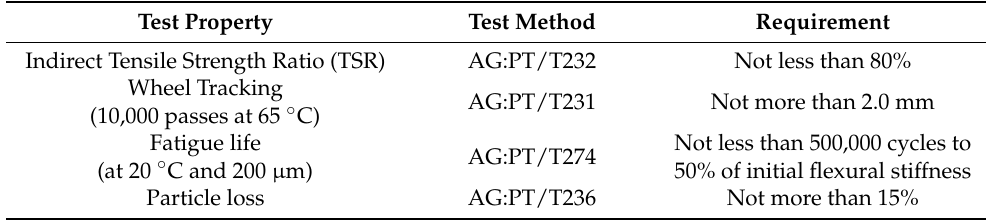
Table 2. Performance-related airport asphalt requirements [7].